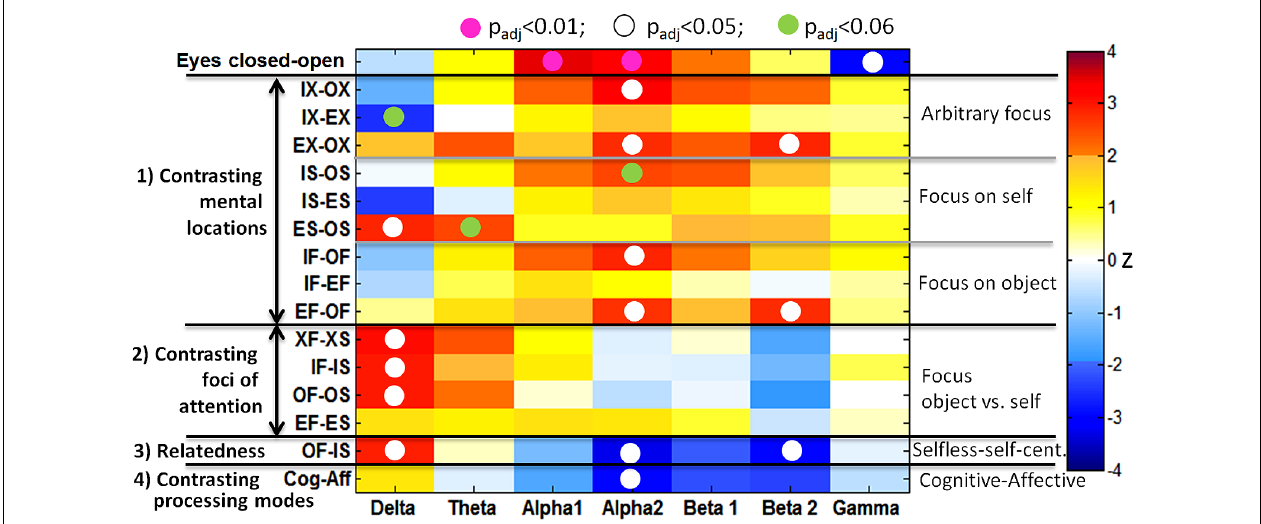
FIGURE 2 | Significances of mean differences between conditions displayed for the global band power measure. Significant contrasts are shown as red and dark-blue fields.The white dots indicate that the z -score